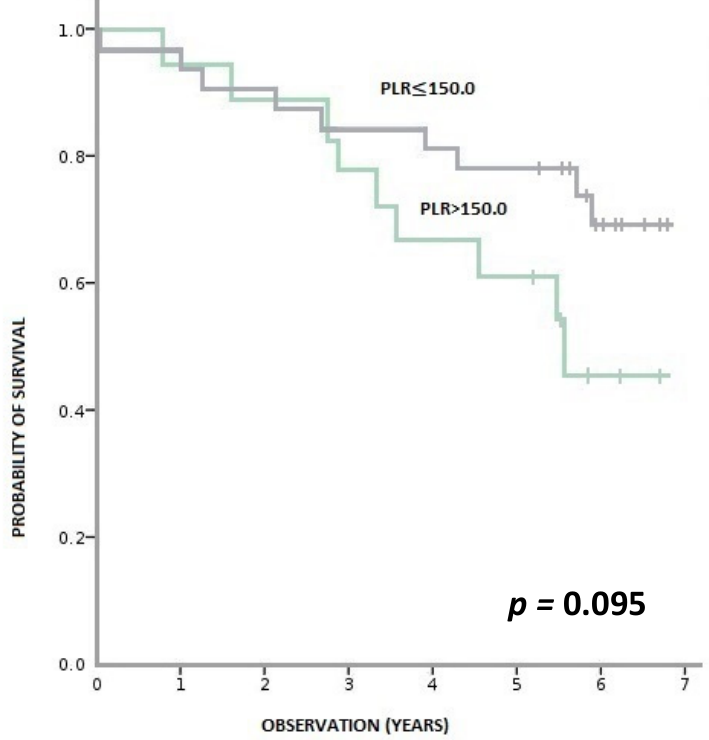
Figure 4. Overall survival according to pre-treatment NLR (neutrophil-to-monocyte ratio).